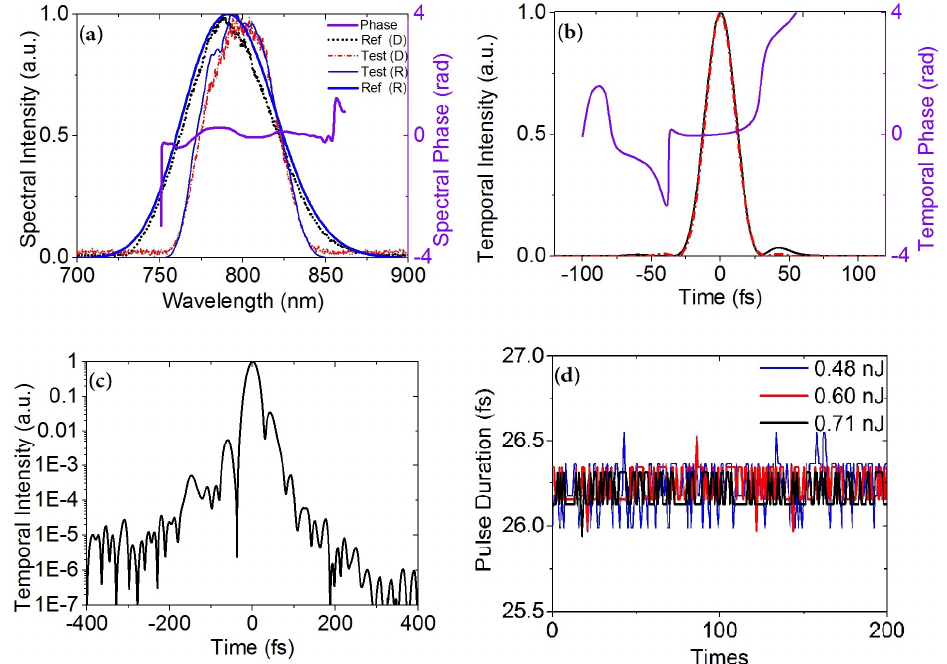
Figure 19. Characterization of femtosecond pulses at 84-MHz repetition rates. ( a ) Reconstructed (R) and directly measured (D) spectra of the input unknown (test) pulse and the TG reference pulse. ( b ) Reconstructed temporal profile (black solid line) and phase of the input unknown pulse (purple line), and the FTL temporal profile of the input unknown pulse (red dashed-dotted line). ( c ) Reconstructed temporal intensity profile on a logarithmic scale. ( d ) Fluctuation of pulse duration at different input pulse energies [63].